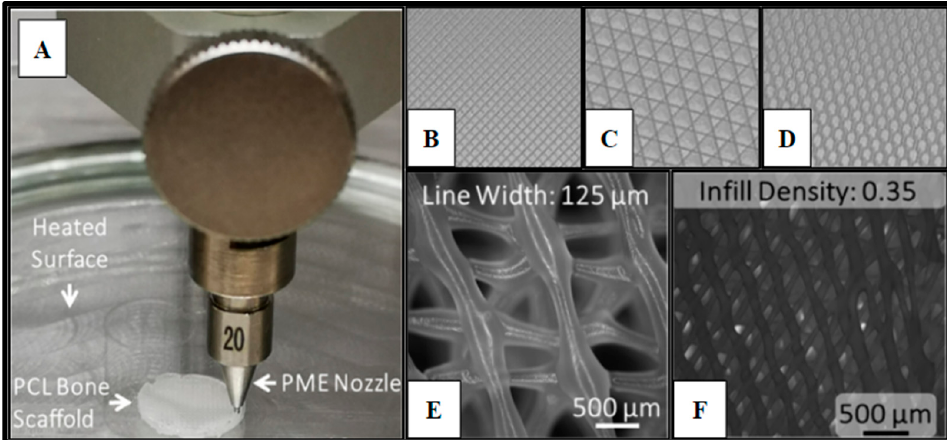
Figure 1. Polycaprolactone (PCL) 3D-printed scaffold fabrication. Panel ( A ) demonstrates the PME process for scaffold microfabrication. Panels ( B – D ) display the infill patterns for the tested scaffold designs: ( B ) Rectangular; ( C ) Cubic; ( D ) Honeycomb. Panel ( E ) presents the honeycomb line width parameter captured on a fluorescence microscope with a 2X magnification (B2X, Keyence, Itasca, IL). Panel ( F ) displays infill density.